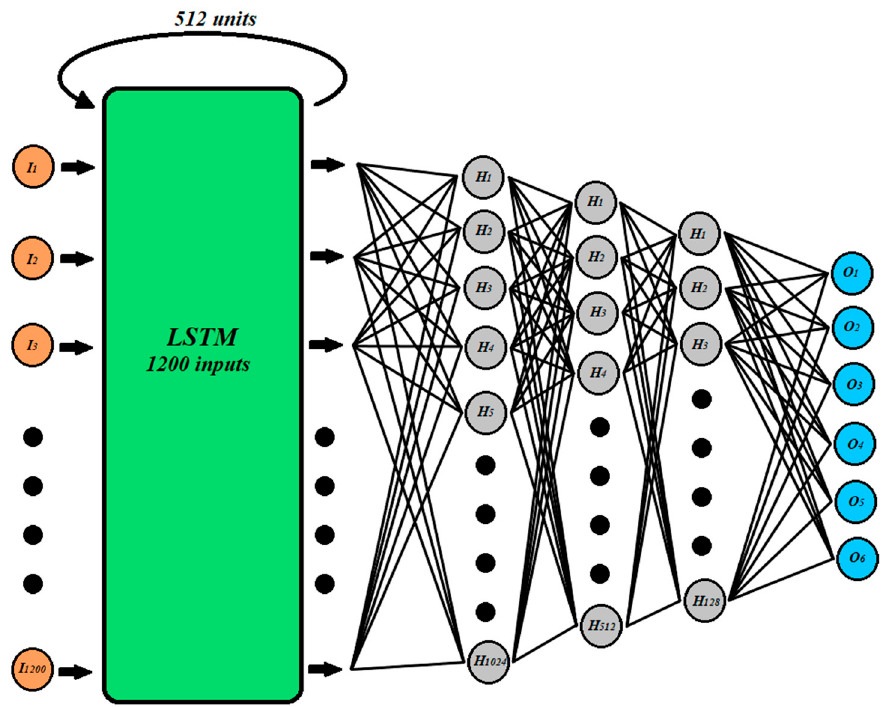
Figure 7. Visual representation of the neural network for gesture–emotion classification. Table 1. Comparison of evaluations obtained by the neural network vs. human beings.